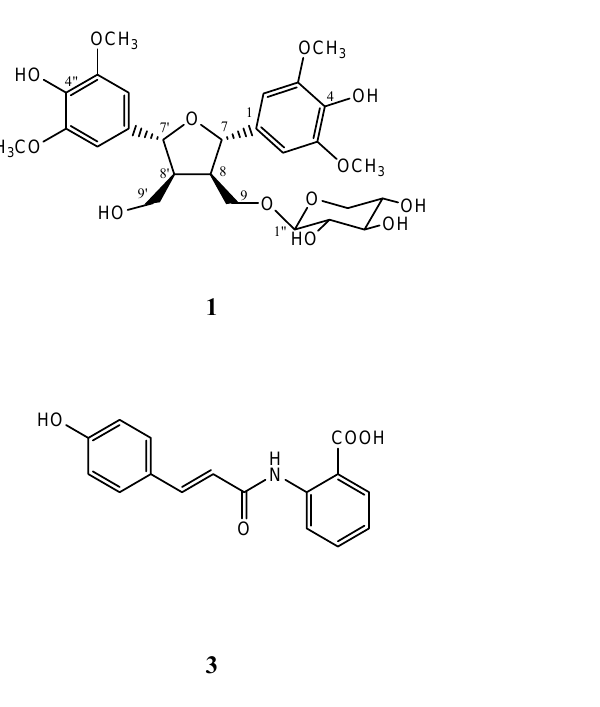
Figure 1. Structures of compounds 1–5